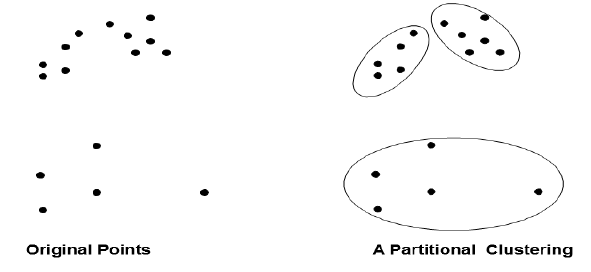
Figure 3. Spherical shapes produced from Partitioning clustering